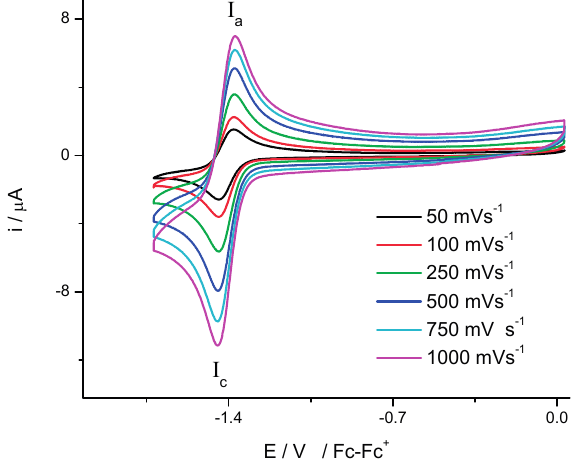
Figure 1. Compound 3 cyclic voltammogram in the presence of 0.1 M, tetrabutyl ammonium hexafluorophosphate (TBAPF 6 ) in DMSO. Scan rate from 50 to 1000 mV·s − 1 . The working electrode used was